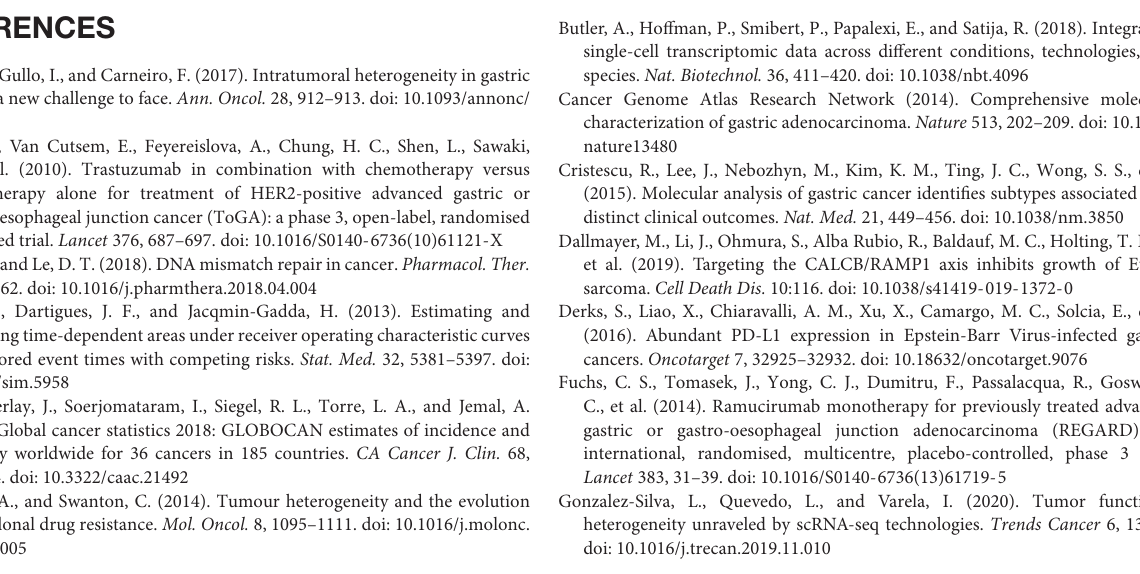
Supplementary Figure 1 | (A) Quality control in the single-cell RNA sequencing analysis. (B) The HVGs and the top 20 HVGs were labeled. (C) The standard deviation explained by PC. (D) The top (ranked by log fold change) marker genes for each malignant cell clusters. Supplementary Figure 2 | (A) Most cluster markers were not included among the overlapping up- or down-regulated genes in STAD. (B) Few malignant and non-malignant cell markers were included among the malignant cell cluster